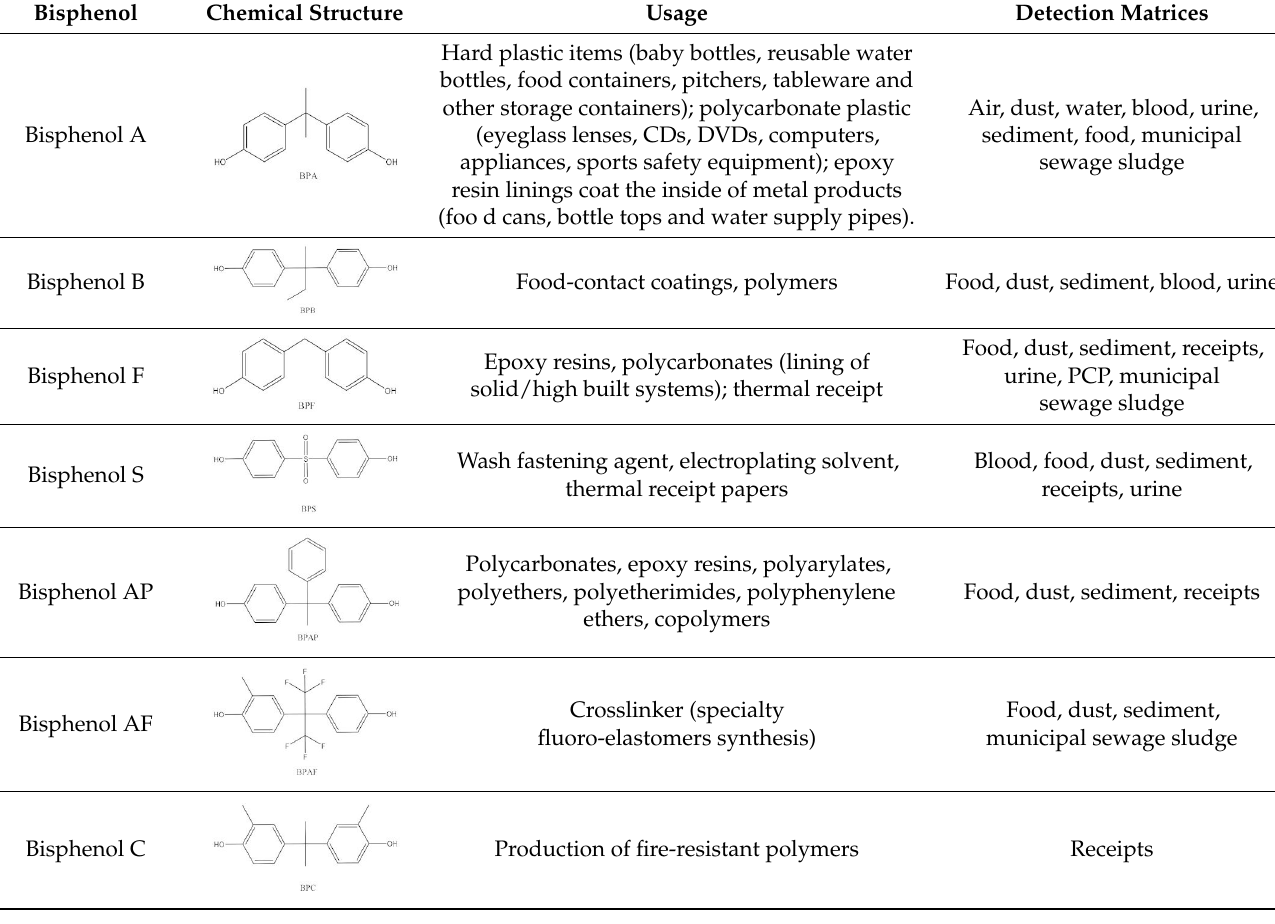
Table 1. The chemical structure of BPA and its analogues and detection